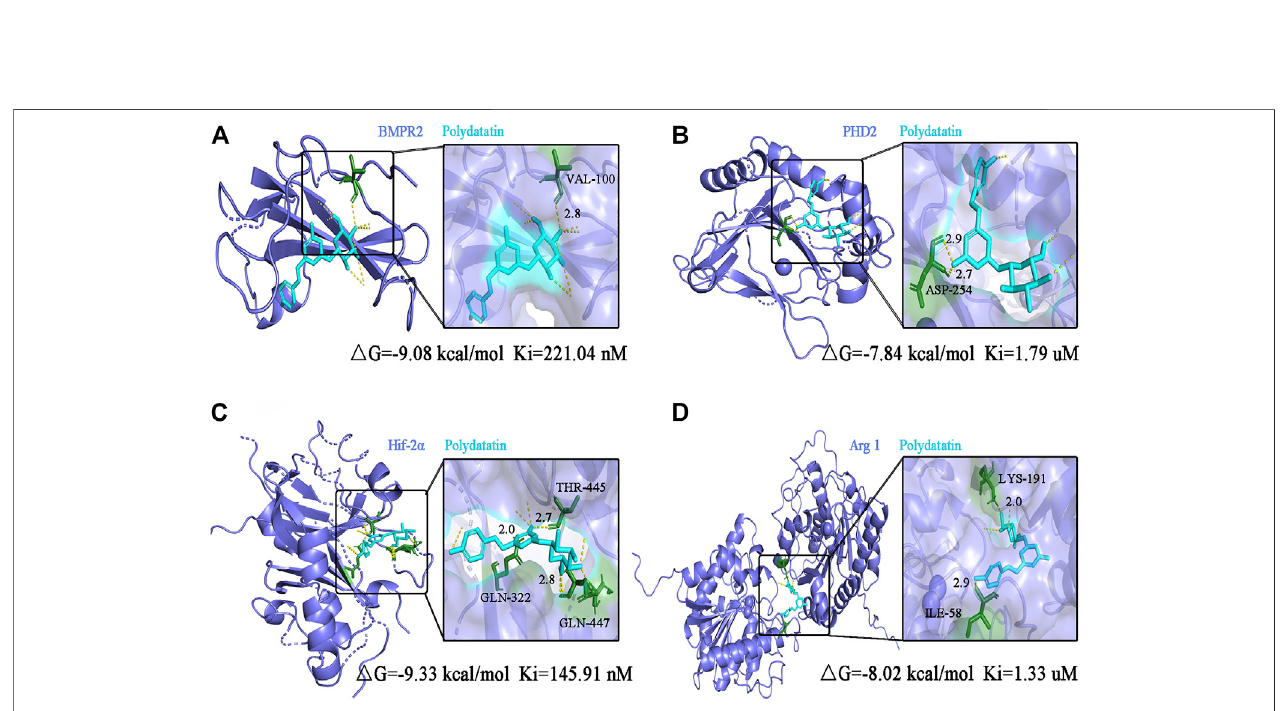
FIGURE 7 | Molecular docking analysis of polydatin to key targets of PAH induced by MCT. (A – D) Complex model of polydatin to human BMPR2 (A) , PHD2 (B) , HIF-2 α (C) and Arg1 (D) rendered in backbone cartoon (left) or in molecular surface (right).